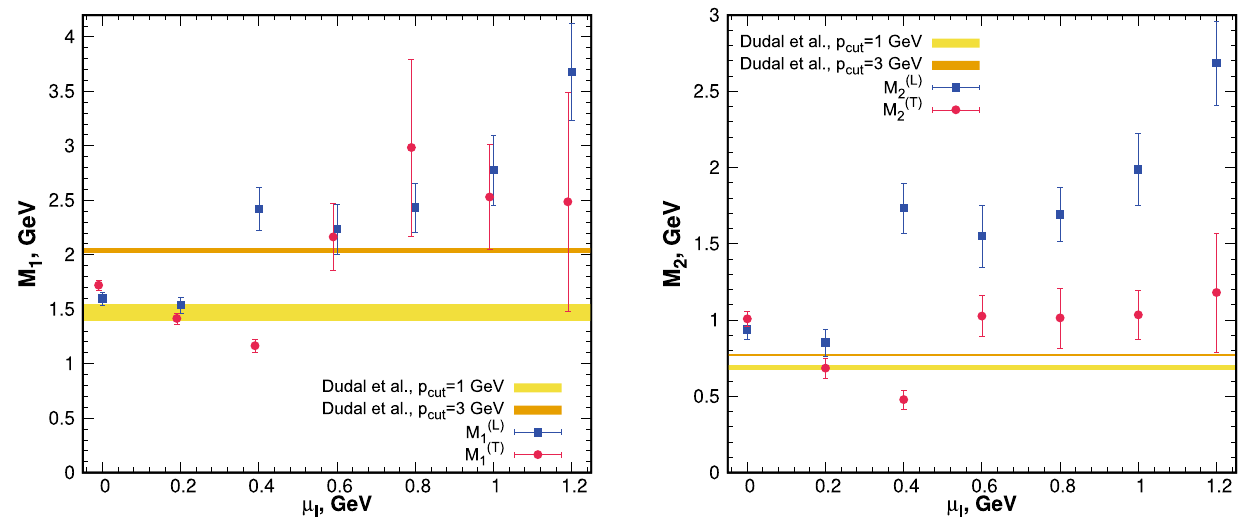
Fig. 4 The propagators D L (left) and D T (right) as functions of μ I at different values of p . Note logarithm scale on the y axis